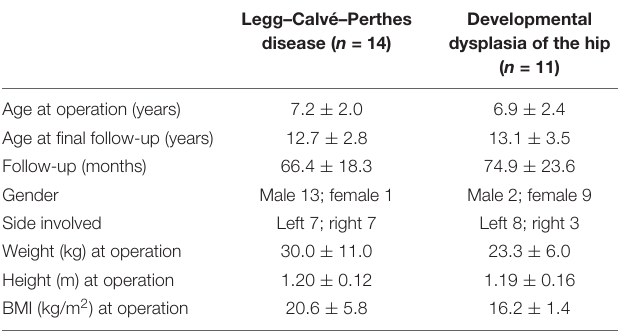
TABLE 1 | Baseline demographic features and operative characteristics of the patients in the study. Legg–Calvé–Perthes disease ( n = 14)